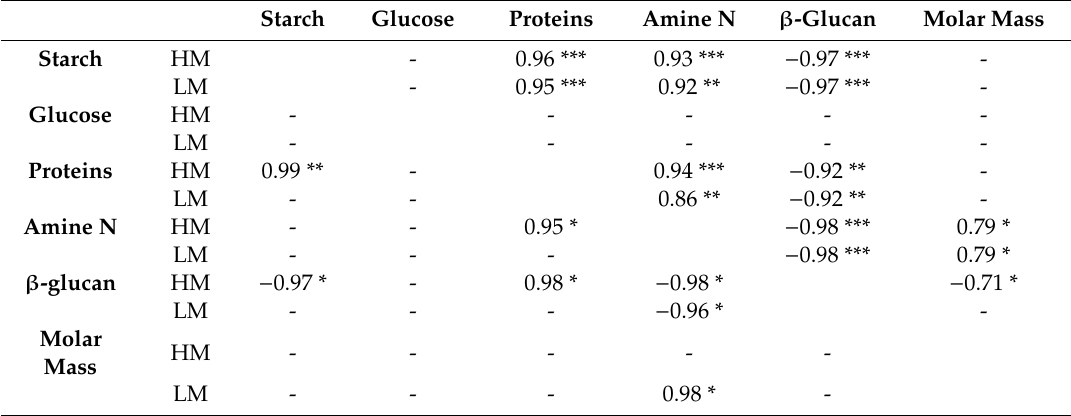
Table 4. Pearson correlation coe ffi cient and partial correlation coe ffi cient between